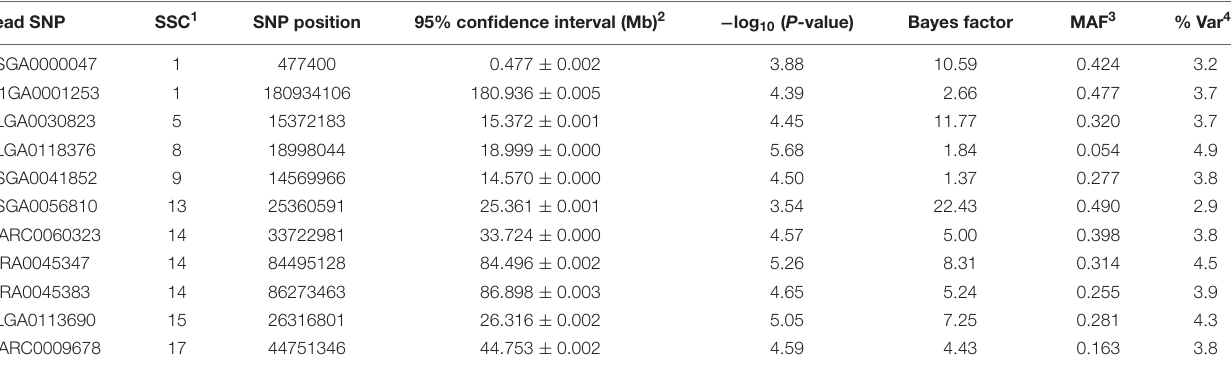
TABLE 5 | Genomic regions and corresponding lead SNPs identified by single- and multi-locus GWAS for the Ca/P ratio. Lead SNP